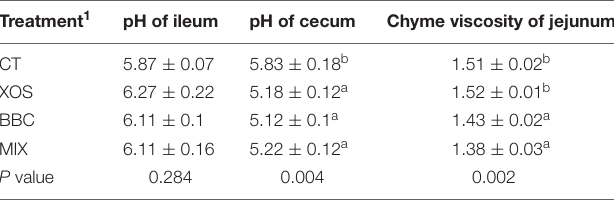
TABLE 2 | The effect of XOS and Pediococcus acidilactici BCC-1 supplementation on growth performance of broilers from 1–21 d. Treatment